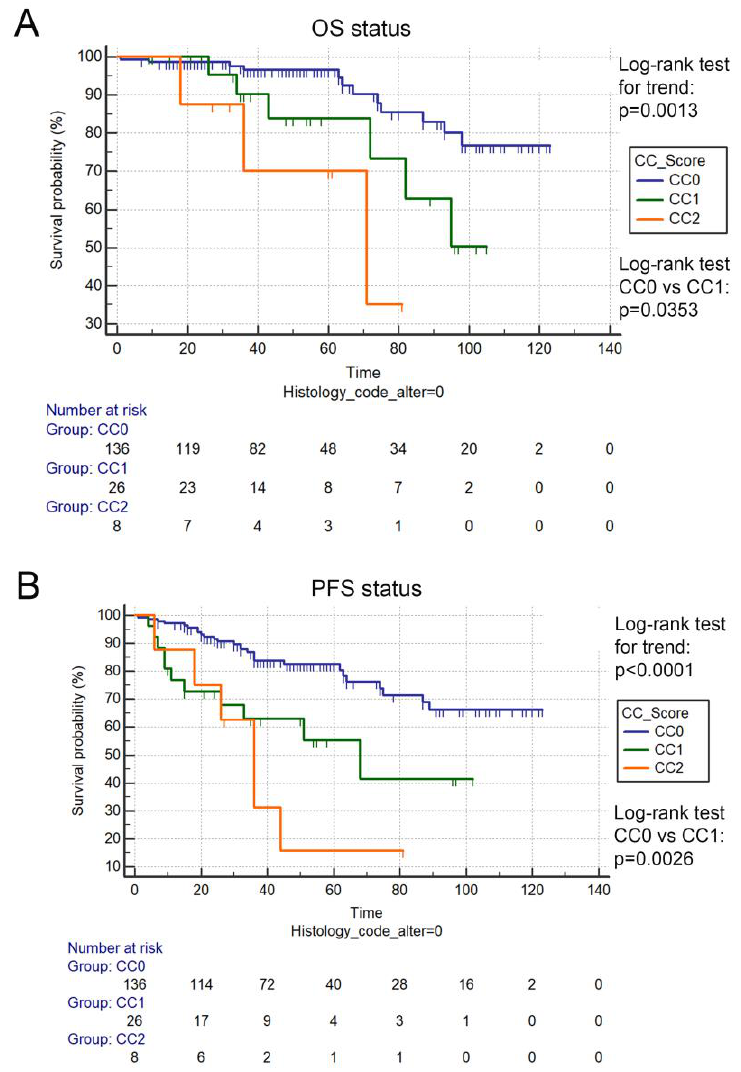
Figure 3. Prognostic role of CC score in LAMN. CC score was prognostic when using Log-rank test for trend, when comparing LAMN patients with CC0, CC1, and CC2 scores in the case of OS ( p = 0.0013, ( A ) and PFS ( p < 0.0001), ( B )). Interestingly, when comparing LAMN patients with CC0 vs. CC1 situation, there was a significant difference in OS (110.8 vs. 86.5 months, p = 0.0353, ( A ) and PFS (97.8 vs. 60.8 months, p = 0.0026), ( B )). Months for OS and PFS are described as means.